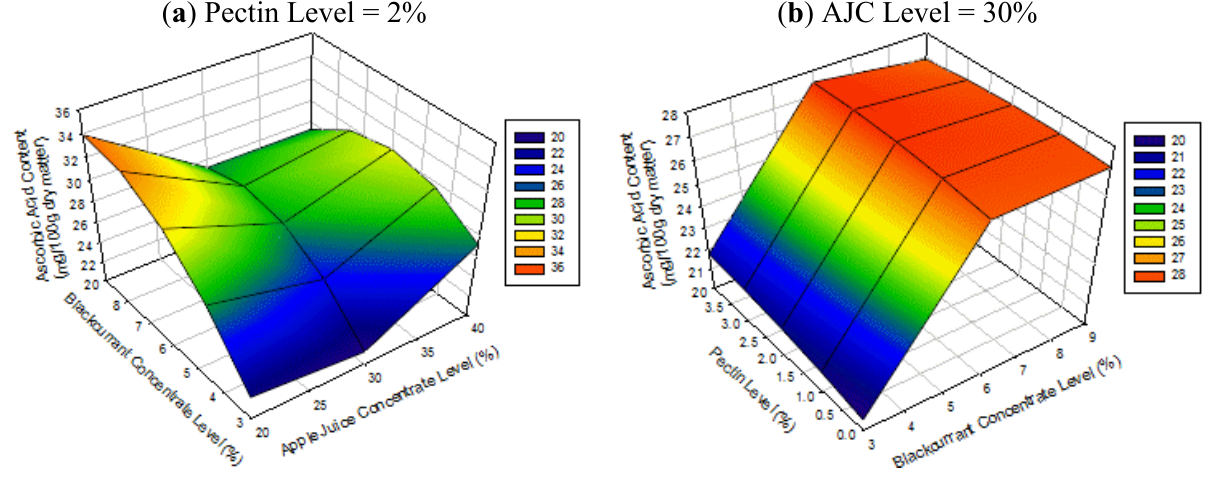
Figure 5. Surface plots for ascorbic acid content of apple-blackcurrant fruit leather as affected by blackcurrant concentrate (BCC) and apple juice concentrate (AJC) levels ( a ) and pectin and BCC levels ( b ) with the third factor set at the middle level (legend shows the range of values on the response